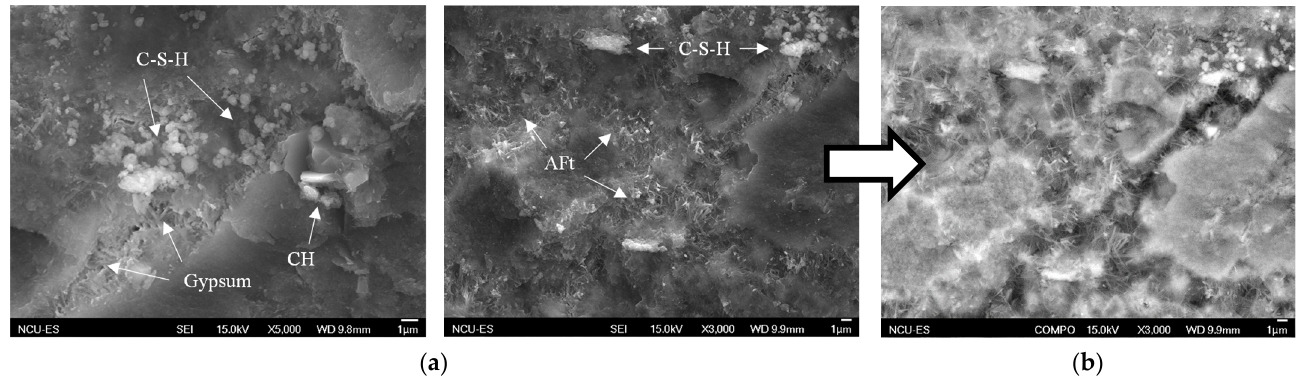
Figure 5. SEM micrograph of hydration products. ( a ) SEI mode; ( b ) BEI mode.